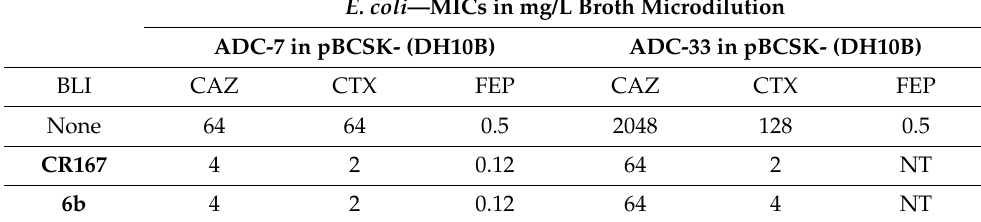
Table 3. Antimicrobial susceptibility testing results for E. coli isolates containing cloned ADC-7 and ADC-33 using broth microdilution. The inhibitors CR167 and 6b were used at 10 mg/L. E. coli —MICs in mg/L Broth Microdilution ADC-7 in pBCSK-